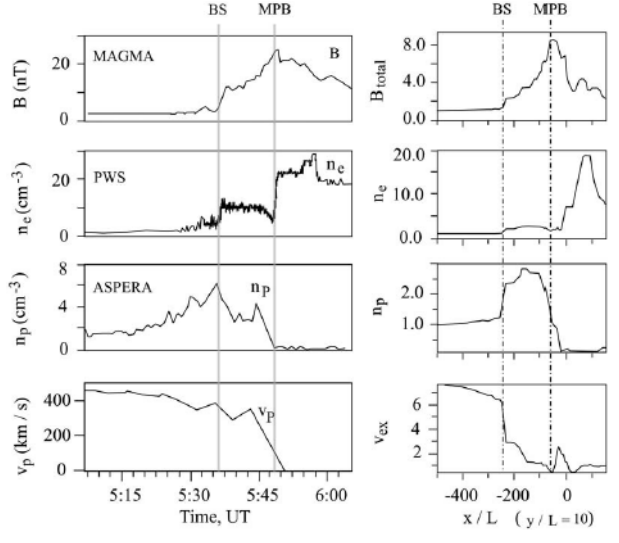
Fig. 1a. Comparison between Phobos-2 measurements (left pan- els) and bi-ion fluid simulations (right panels) for the third elliptical orbit, after Sauer and Dubinin (2000).